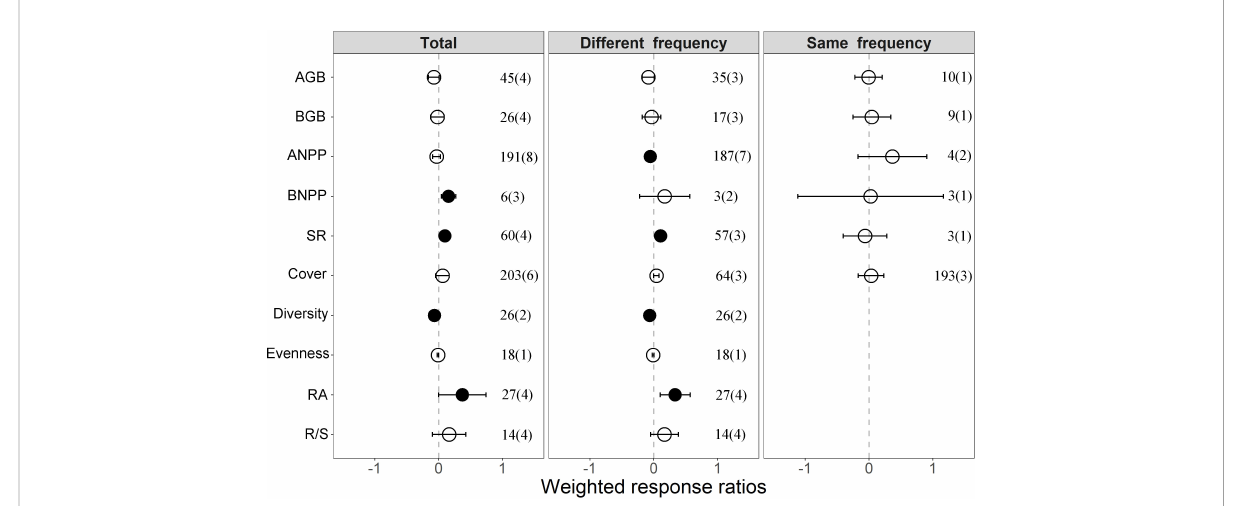
FIGURE 2 Responses of plant productivity and community structure to intra-annual precipitation patterns (including total precipitation pattern group, different precipitation frequency group and same precipitation frequency group). Values are weighted response ratios and their 95% con fi dence intervals (95% CI). Values indicate the intensity of the impact of altered intra-annual precipitation distribution on plant productivity and community structure relative to the values in the ambient treatment. The vertical dashed line represents weighted response ratios = 0. If 95% CI did not overlap with zero, the effects of precipitation pattern on variables were considered signi fi cant (denoted by black circles). Numbers corresponding to each variable represent the number of data observations, and the number in parentheses represents the number of studies. AGB, aboveground biomass; BGB, belowground biomass; ANPP, aboveground net primary productivity; BNPP, belowground net primary productivity; SR, species richness; RA, relative abundance; R/S, root – shoot